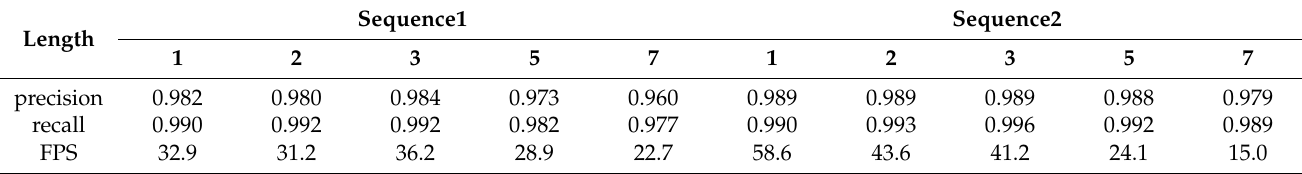
Table 2. Comparison results of accuracy and recall of image sequences of different lengths for sequence1 and